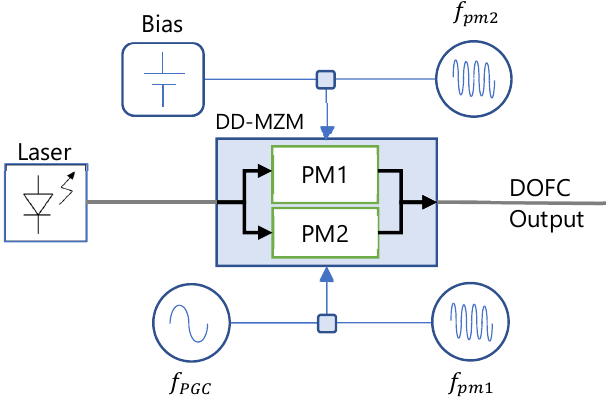
Figure 3. Basic scheme of a dual optical frequency comb (DOFC) generated by a dual-drive Mach– Zehnder modulator (DD-MZM) and phase-generated carrier (PGC). PM, phase modulator.